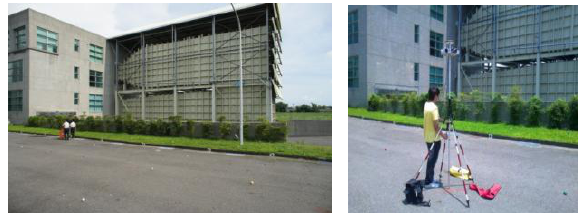
Figure 8. Outdoor calibration